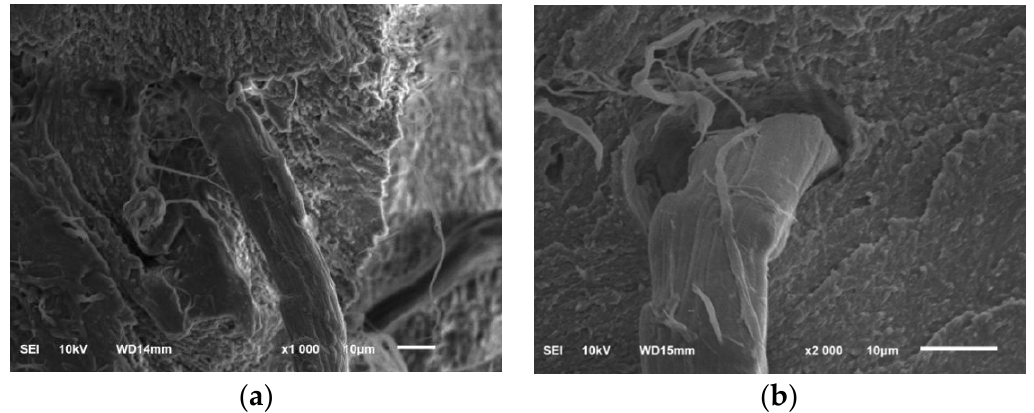
Figure 20. SEM image of cross section of PPTA modified composite material: ( a ) stretched section view and ( b ) impact section.